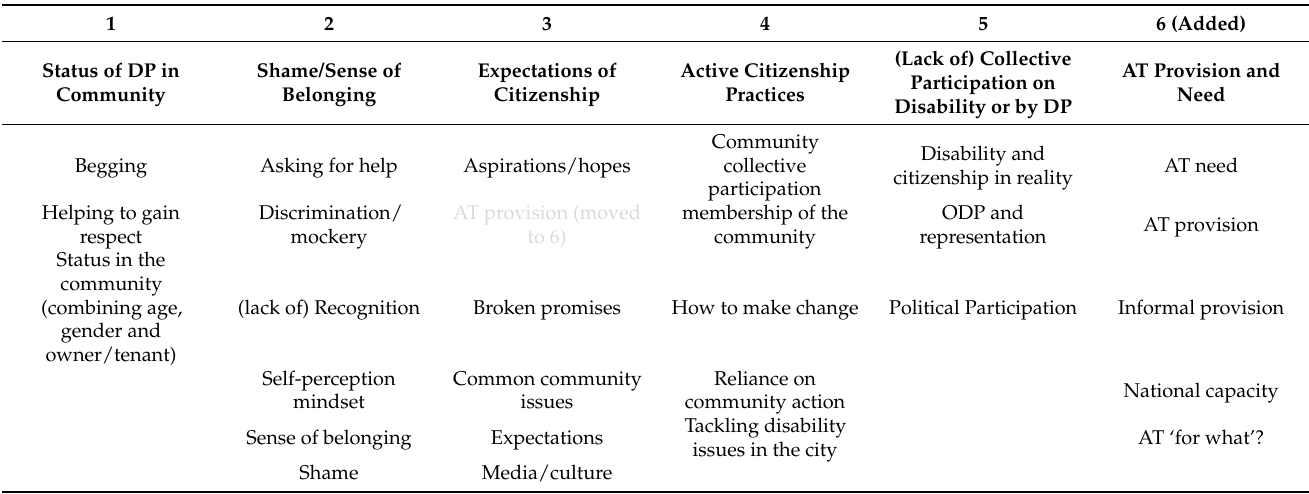
Table A1. Final Coding